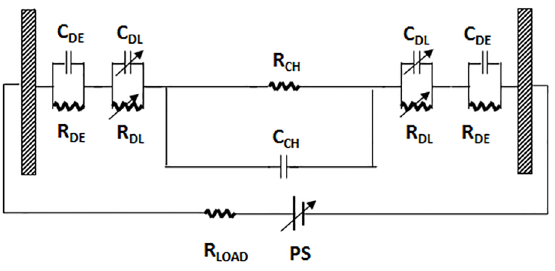
Figure 3. The equivalent circuit model for the electrical lysis device. The electrical lysis chamber modelled by an equivalent electrical circuit following the suggestions of reference [15].